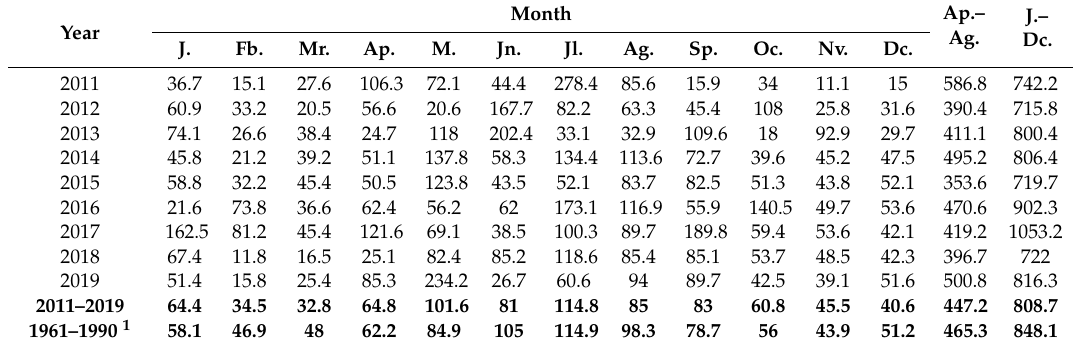
Table 2. Sum of precipitation (mm) during the course of study.